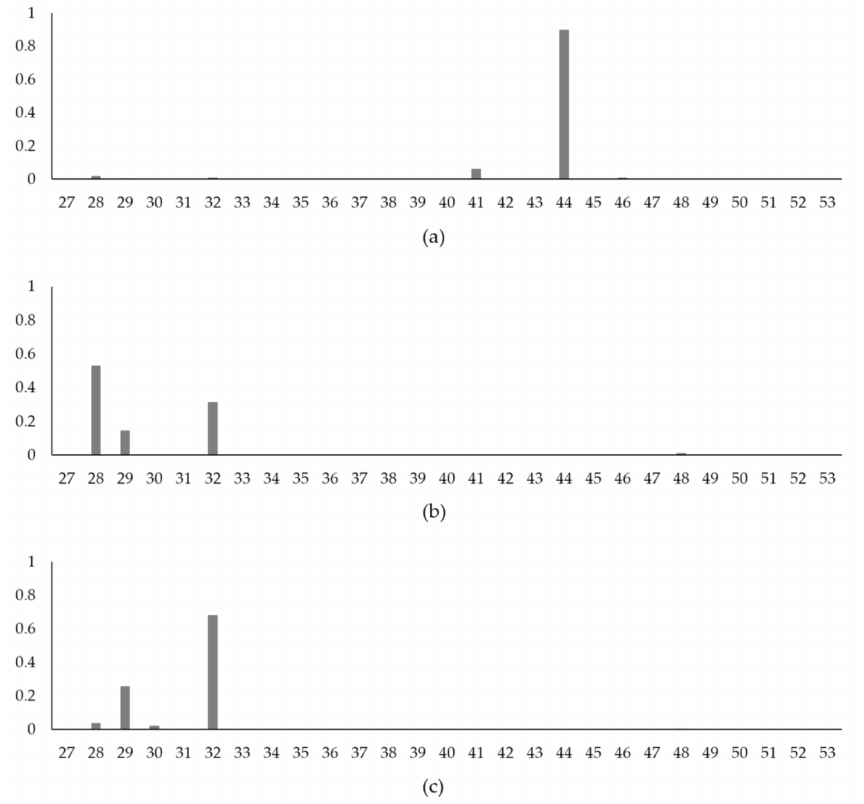
Figure 14. Values of P i ( d ) at location indices from 27 to 53 under realization R13: ( a ) unified model 1 with 2 sensors at (26, 53); ( b ) unified model 2 with 4 sensors at (9, 26, 46, 53); and ( c ) unified model 3 with 6 sensors (9, 19, 26, 33, 46,